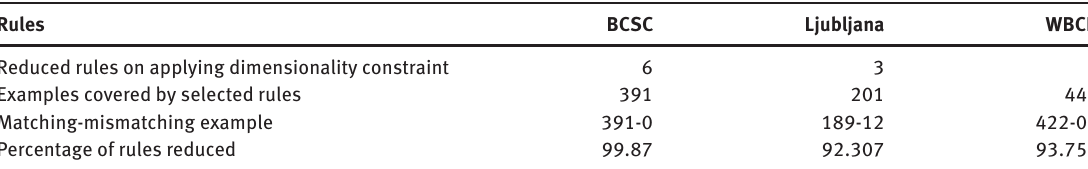
Table 6: Number of Dimensionality Based Reduced Association Rules Obtained for All Three Breast Cancer Data sets Used for Feature